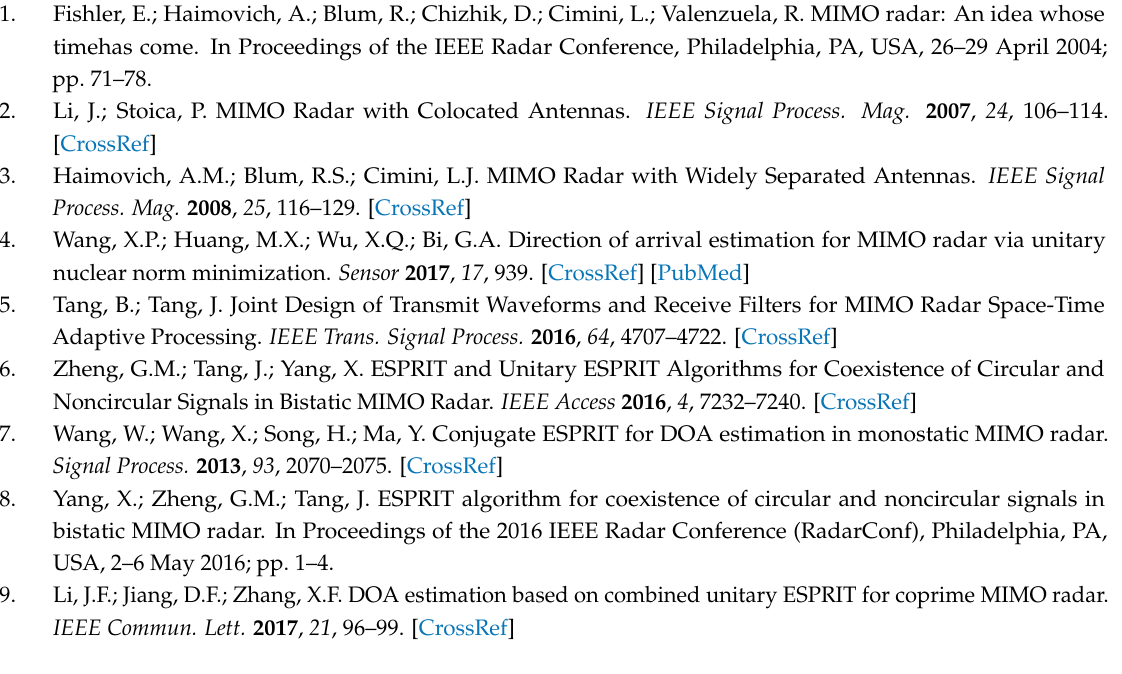
Figure 7. Angle tracking with different values of Mr .